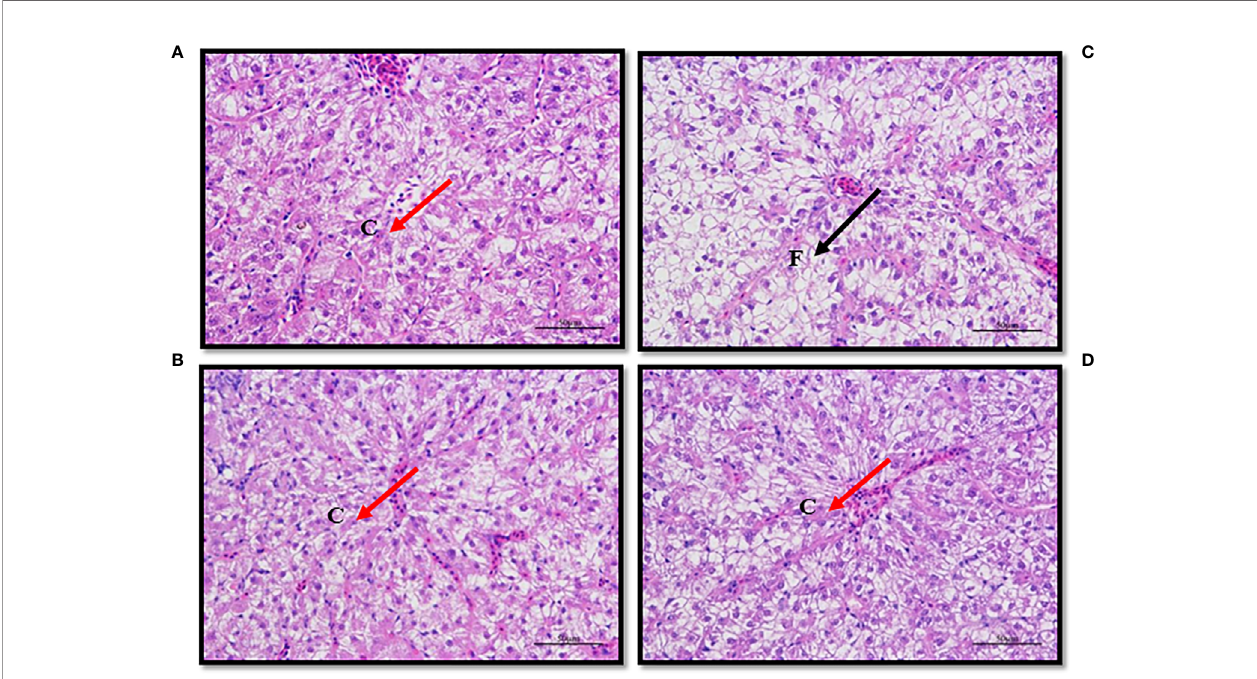
FIGURE 4 | Paraf fi n section of liver of juvenile black seabream ( Acanthopagrus schlegelii ) fed the experimental diets (Control: 11% crude lipid; HFD: high-fat diet; HFD+B1: HFD +betaine (10g/kg); HFD+B2: HFD + betaine (20 g/kg)) for 8 weeks. The liver sections were stained with H&E to enhance the contrast (400X).